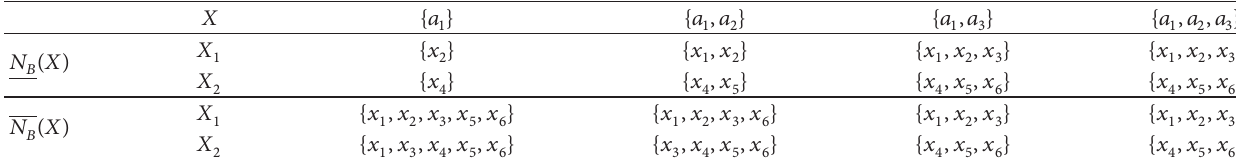
Table 7: Approximations of object subsets on different test